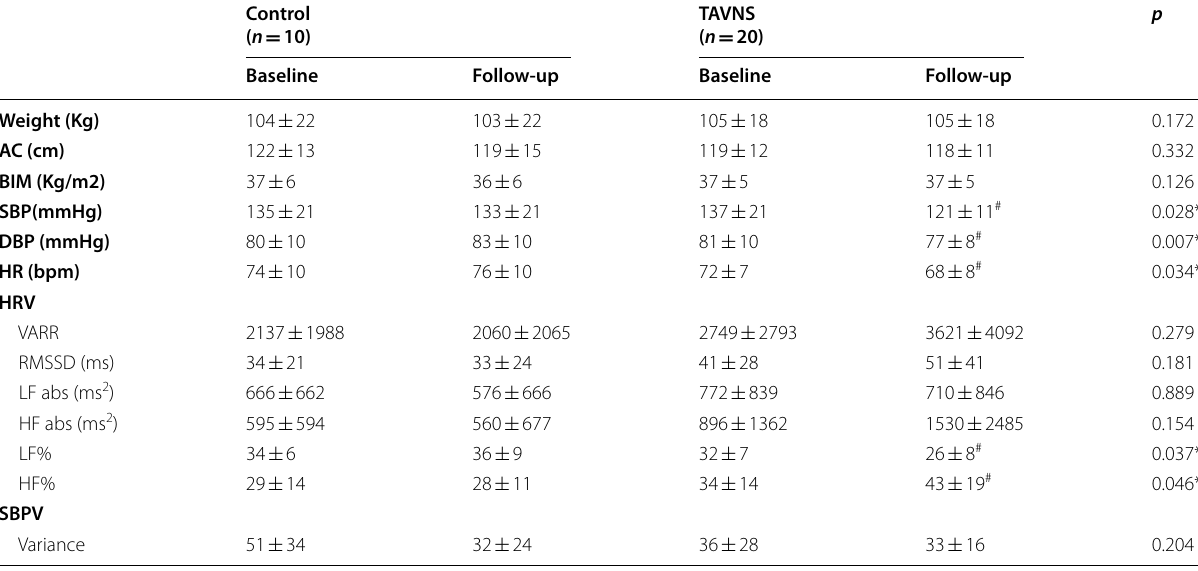
AC Abdominal circumference, BMI Body mass index, SBP Systolic blood pressure, DBP Diastolic blood pressure, HR Heart rate, HRV Heart rate variability, VARR Total variance of RR interval, RMSSD Square root of the mean of the square of successive differences between adjacent RR intervals, LF abs Low frequency spectral power, HF abs High frequency spectral power, SBPV Systolic Blood Pressure variability, Variance Total SBPV power # p < 0.05 * p <